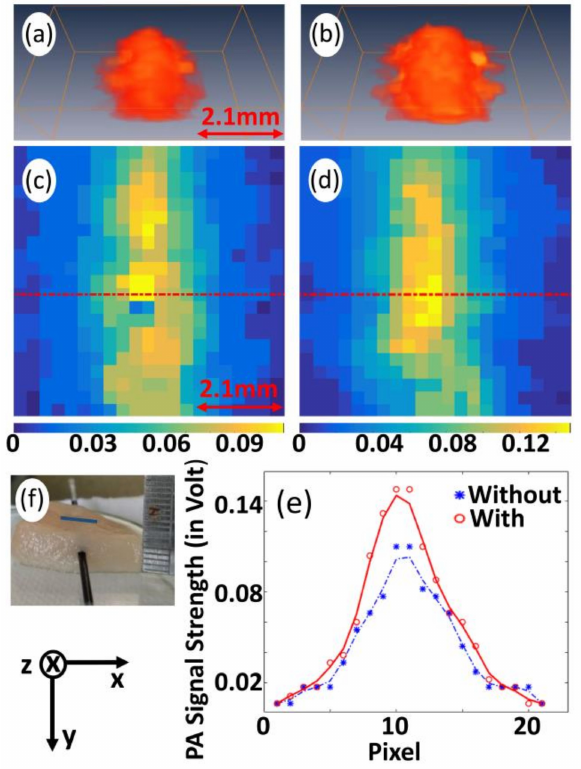
Figure 9. 3D images representative of P 0 obtained without ( a ) and with pre-illumination ( b ), while ( c , d ) give corresponding 2D images for plane (at y = 3). ( e ) Variation of P 0 and P lines indicated in ( c , d ). Photograph of chicken breast tissue ( f ) in which transparent glass of inner diameter ( ∼ 1 mm) filled with methylene blue, thereby, mimicking deep-seated blood vessels is inserted at depth ∼ 2.5 mm (as it is observed from attached scale). Marked line indicates region for raster scanning. Arrow heads in both sides of scale bar (being included in the figure) indicate measure of entire length of the image along x